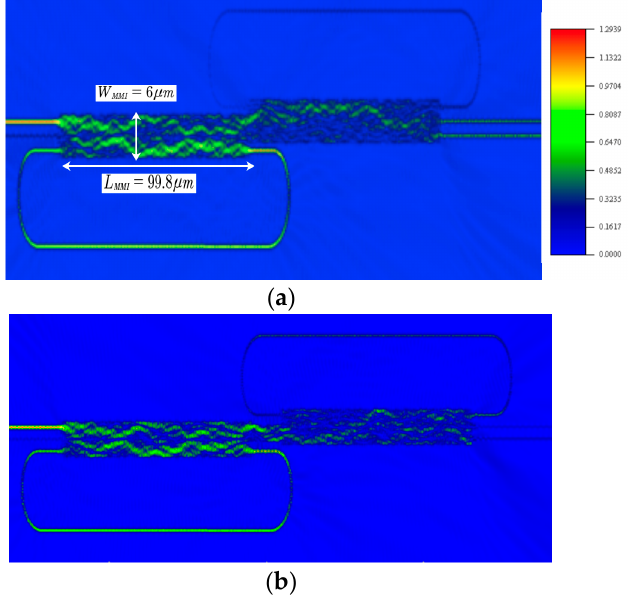
Figure 8. FDTD simulations for input signal at input port 1 for the EIT scheme of Figure 5a,b at wavelength λ = 1550 nm .